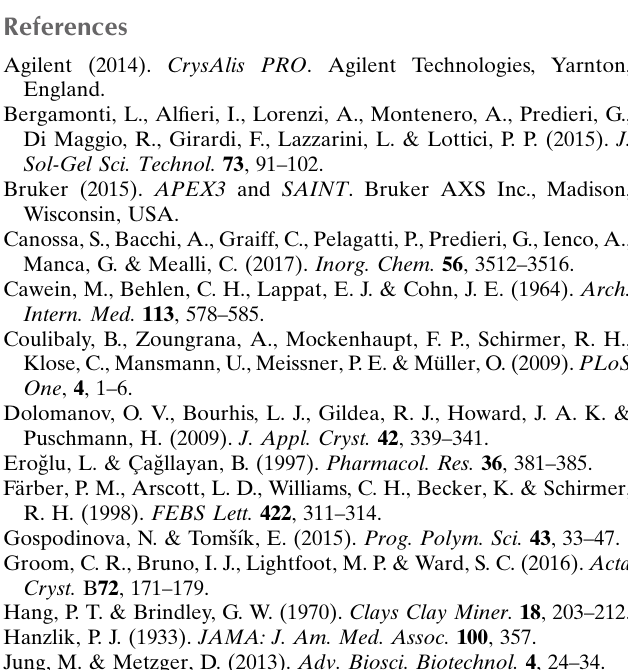
Crystal data Chemical